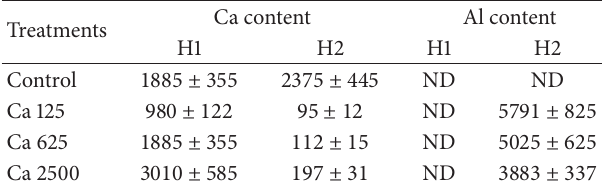
Table 1: Calcium and Al contents ( 𝜇 gg − 1 dry matter) in the roots obtained before (H1) and after (H2) exposure to 100 𝜇 M Al for 6d. Values are the means ± SE of three